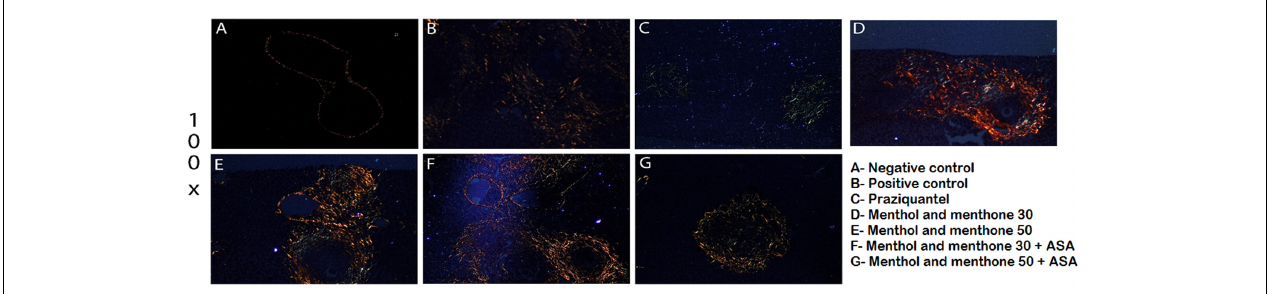
FIGURE 3 | Liver histology stained with Picro Sirius Red. Negative control (A) , positive control (B) , praziquantel (C) , menthol and menthone 30 (D) , menthol and menthone 50 (E) , menthol and menthone 30 + ASA (F) and menthol and menthone 50 + ASA (G) . Picro-Sirius Red/Increase: 100 ×